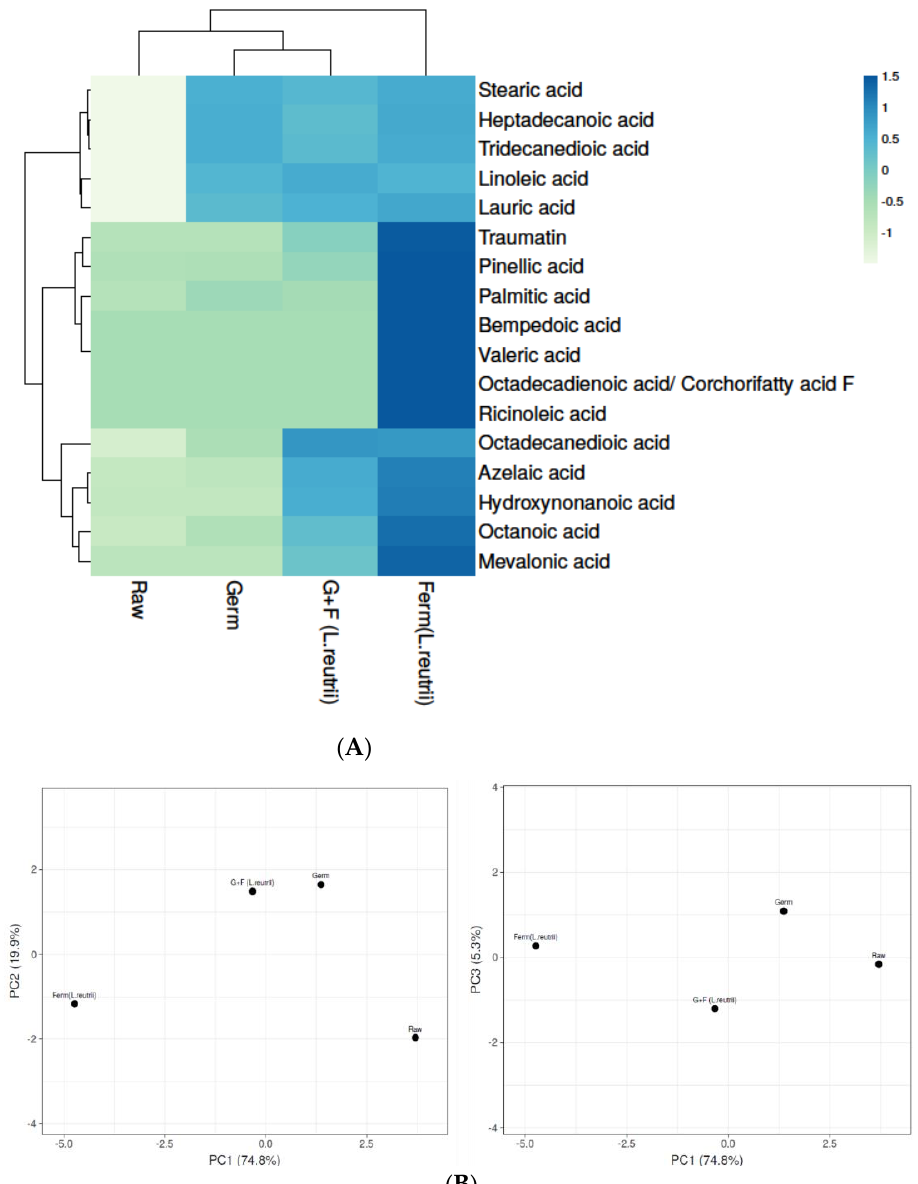
Figure 5. Levels of fatty acid in raw, germinated, fermented ( L. reuterii AKT1) and G+F ( L. reuterii AKT1) samples. ( A ) The heat map shows different levels of fatty acid in samples based on colors, as blue to green represents the level of fatty acids in decreasing order. ( B ) Identification of principal component analysis (PCA) of Raw, Germ, Ferm ( L. reuterii AKT1) and G+F was shown by comparing PC1 with PC2 as well as PC1 with PC3. Germ- germinated brown rice, Ferm- fermented brown rice, G+F- germinated + fermented brown rice.